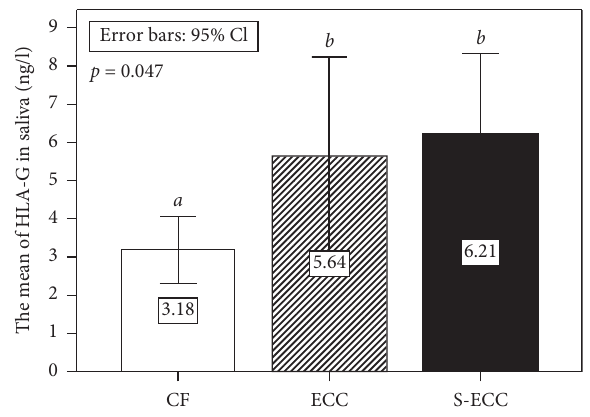
Figure 1: The mean of salivary sHLA-G in each group (std. de- viations a � 2.28, b � 5.51, and b � 6.03). There was statistical dif- ference ( p � 0 . 047) among three groups, considering each HLA-G, separately to the Kruskal–Wallis test (different letters indicate significant differences between